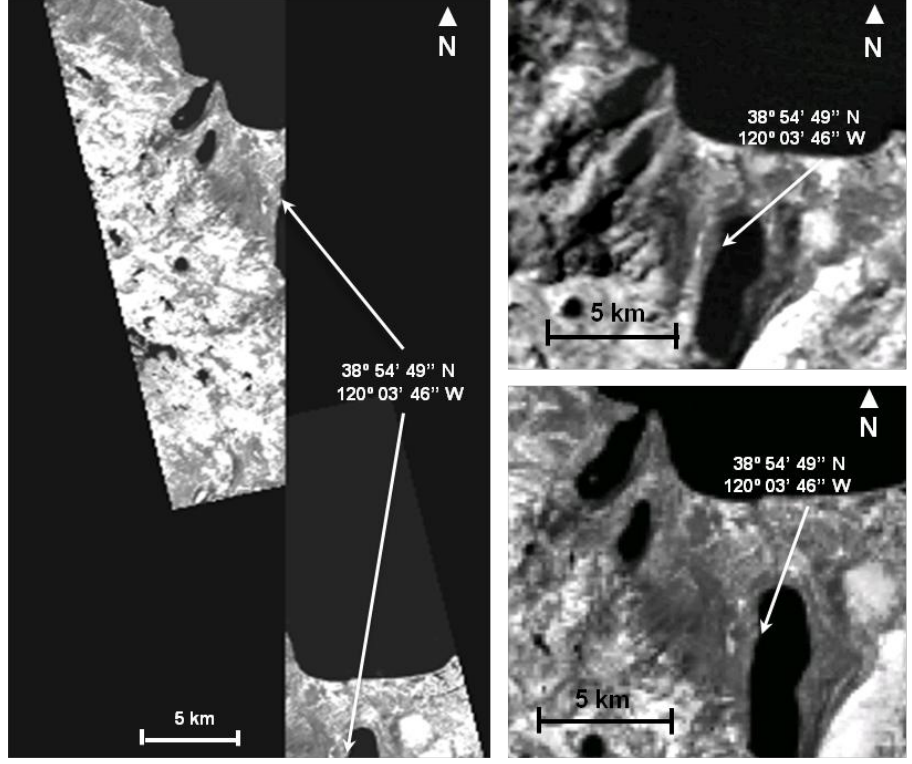
Figure 4. Example data set ( left ) showing a simulated TIRS band of a small subsection of the Lake Tahoe simulated landscape where the two arrays meet. One array is imaging slightly ahead of the satellite ground track and one is imaging slightly behind. Also, an actual Landsat 7 thermal image ( top right ) and a simulated TIRS band 1 image after alignment but before geo-rectification ( bottom right ) are shown to illustrate the radiometric